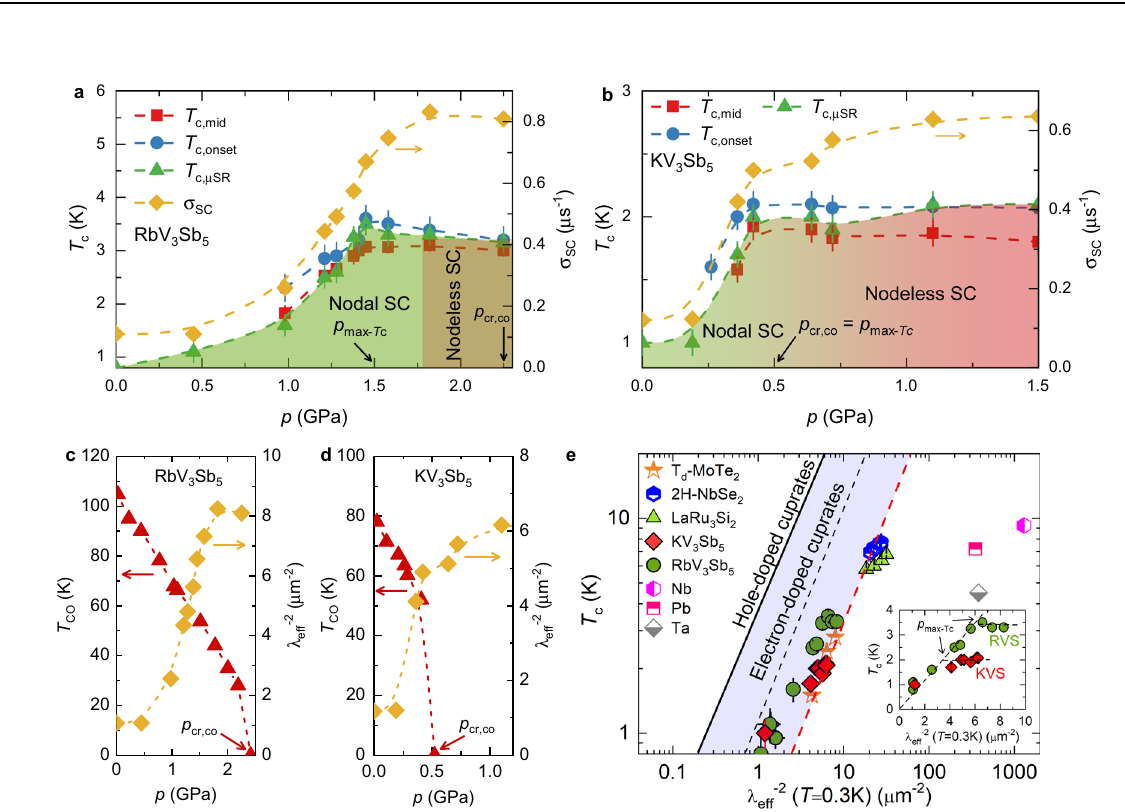
Fig. 2 | Time-reversal symmetry-breaking charge order and superconductivity in (K,Rb)V 3 Sb 5 under pressure. a The pressure dependences of the transition temperatures T * 1 and T * 2 . Temperature dependence of the absolute change of the electronic relaxation rate ΔΓ = Γ ( T ) − Γ ( T > T c ) for KV 3 Sb 5 ( b ) and RbV 3 Sb 5 ( c ) in the